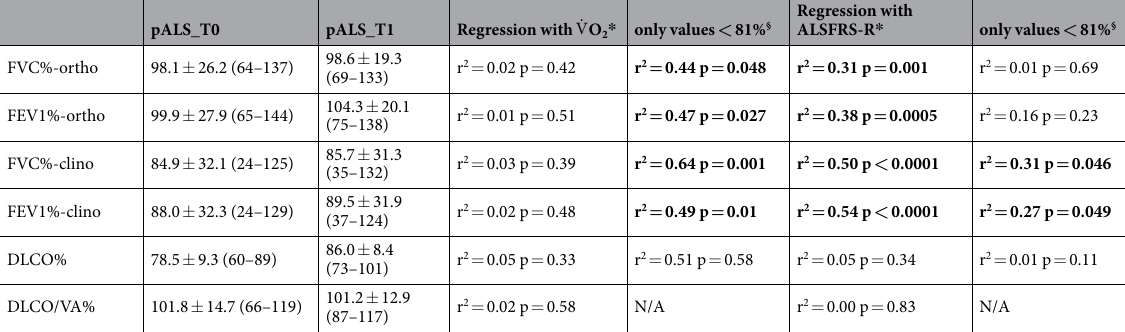
Table 2. Relationship between respiratory test parameters obtained during the CPET and clinical scores in pALS. T0, starting evaluation; T1, second evaluation after 4 months. * Since the slopes and intercepts where not significantly different at T0 and T1, it was possible to calculate one single pooled slope and intercept. § Linear regression analysis was performed again considering only spirometric or DLCO values < 81%. Statistically significant values are reported in bold. N/A, not applicable. FVC, Forced Vital Capacity; FEV1, Forced Expiratory Volume in 1 second, DLCO, Diffusion Lung